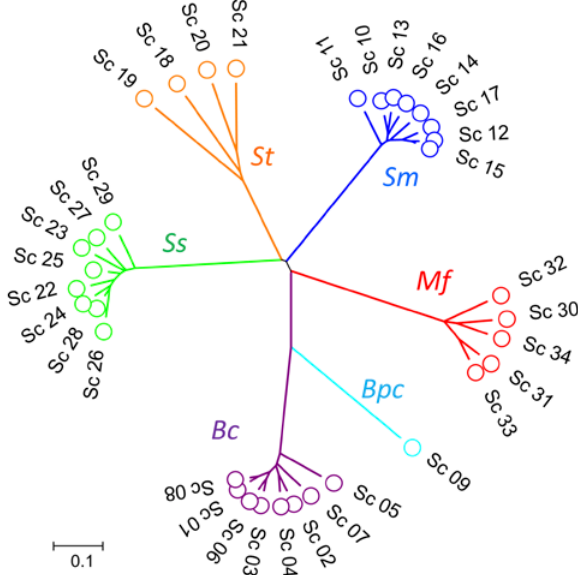
Figure 2. UPGMA dendrogram of 34 Sclerotiniaceae iso- lates examined in this study, constructed with retrotrans- poson data. Isolate identification codes as indicated in Table 1. St = Sclerotinia trifoliorum , SM = Sclerotinia minor , Ss = Sclerotinia sclerotiorum , Mf = Monilinia fructigena , Bc = Botrytis cinerea , Bpc = Botrytis pseudocinerea . The scale bar (0.1) indicates 10% genetic